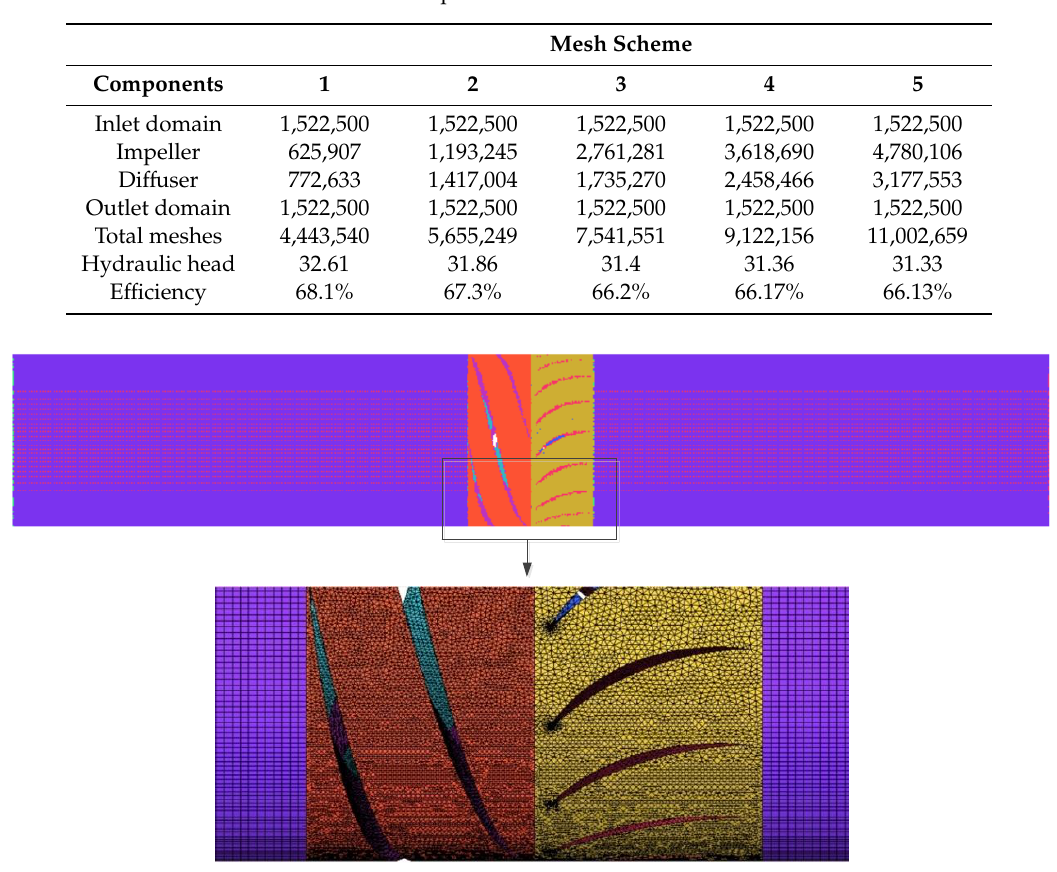
Table 4. Independence test of mesh number.